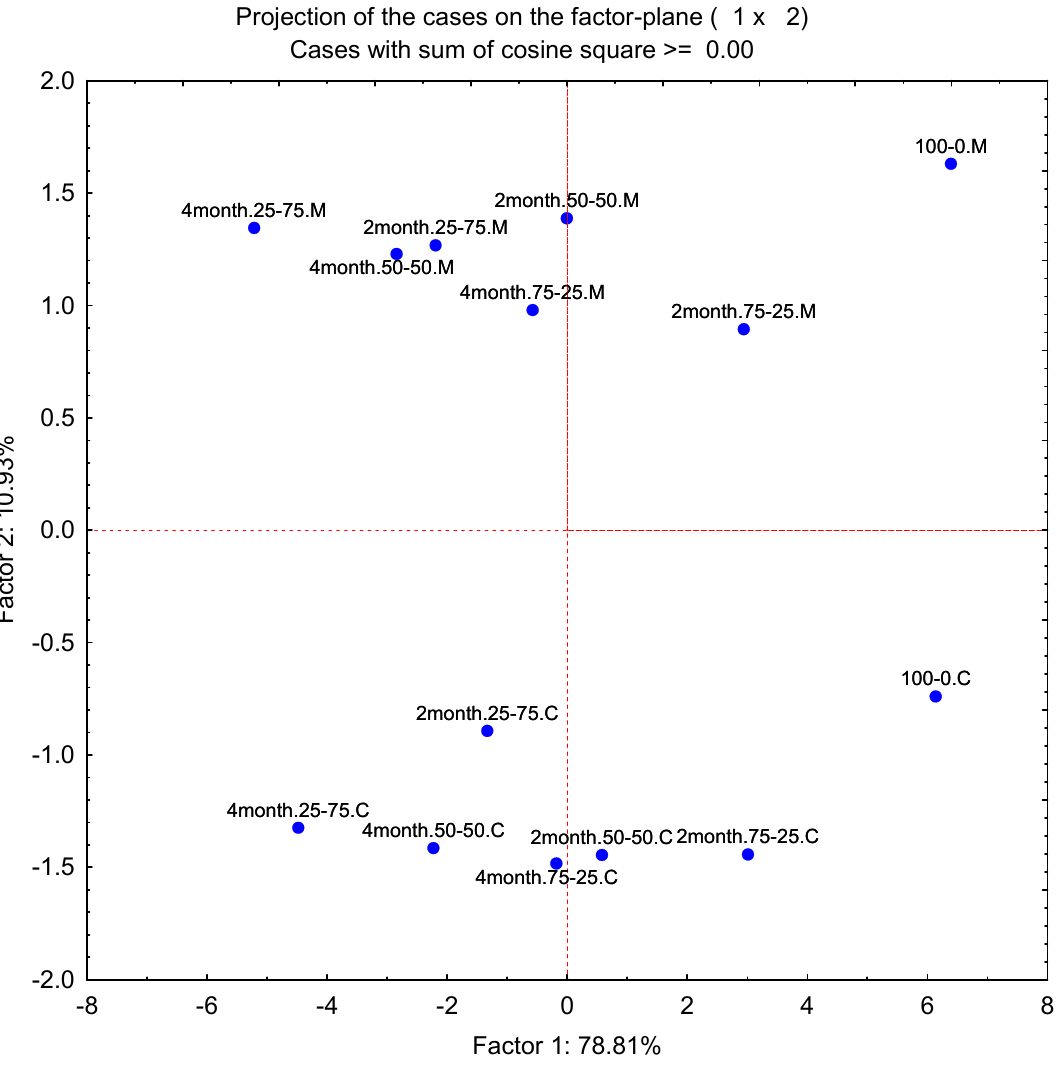
Figure 1. Principal component analysis (PCA) showing the first two principal components (PCs) of descriptive sensory analysis of Pizza cheese. M = Microwave cooking, C = Conventional oven cooking, 2 and 4 months = 2 and 4 months ripened Cheddar cheese, 75:25, 50:50, 25:75 = the first part represents Mozzarella and the second part represents Cheddar cheese proportion in Pizza cheeses.